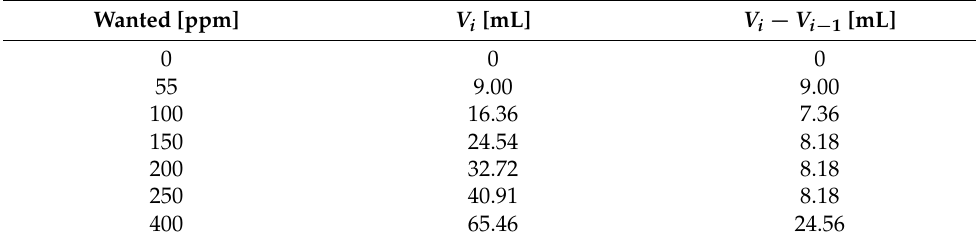
Table 2. A list of each wanted OiW concentration by addition of specific amount of oil. V i represent the total amount of oil added, where V i − V i − 1 represents the amount that should be added to reach the next OiW